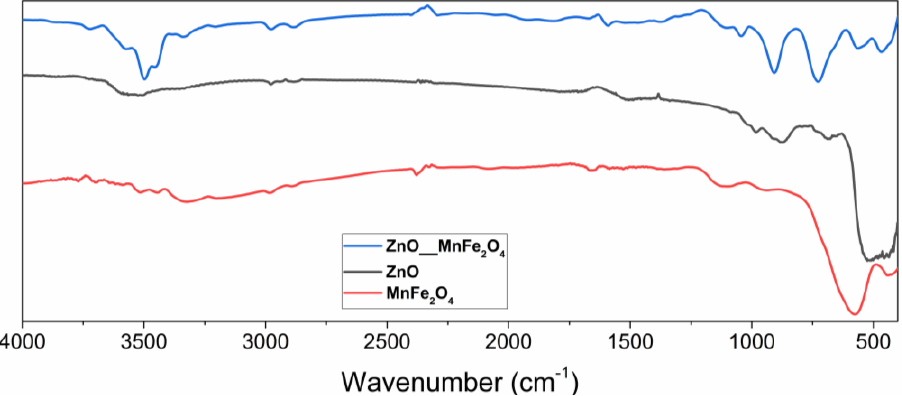
Figure 1. Spectrum in the infrared region of ZnO, MnFe 2 O 4 , and the composite ZnO/MnFe 2 O 4